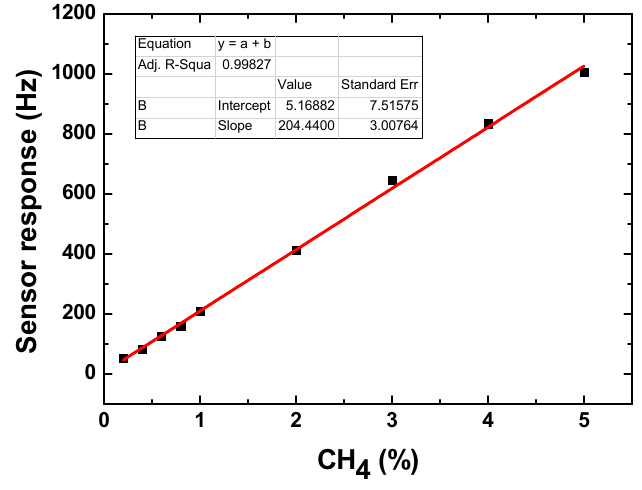
Sensors 2016 , 16 , 73 Figure 10. Frequency shifts of CrypA-coated SAW sensor vs. different concentrations of CH 4 .